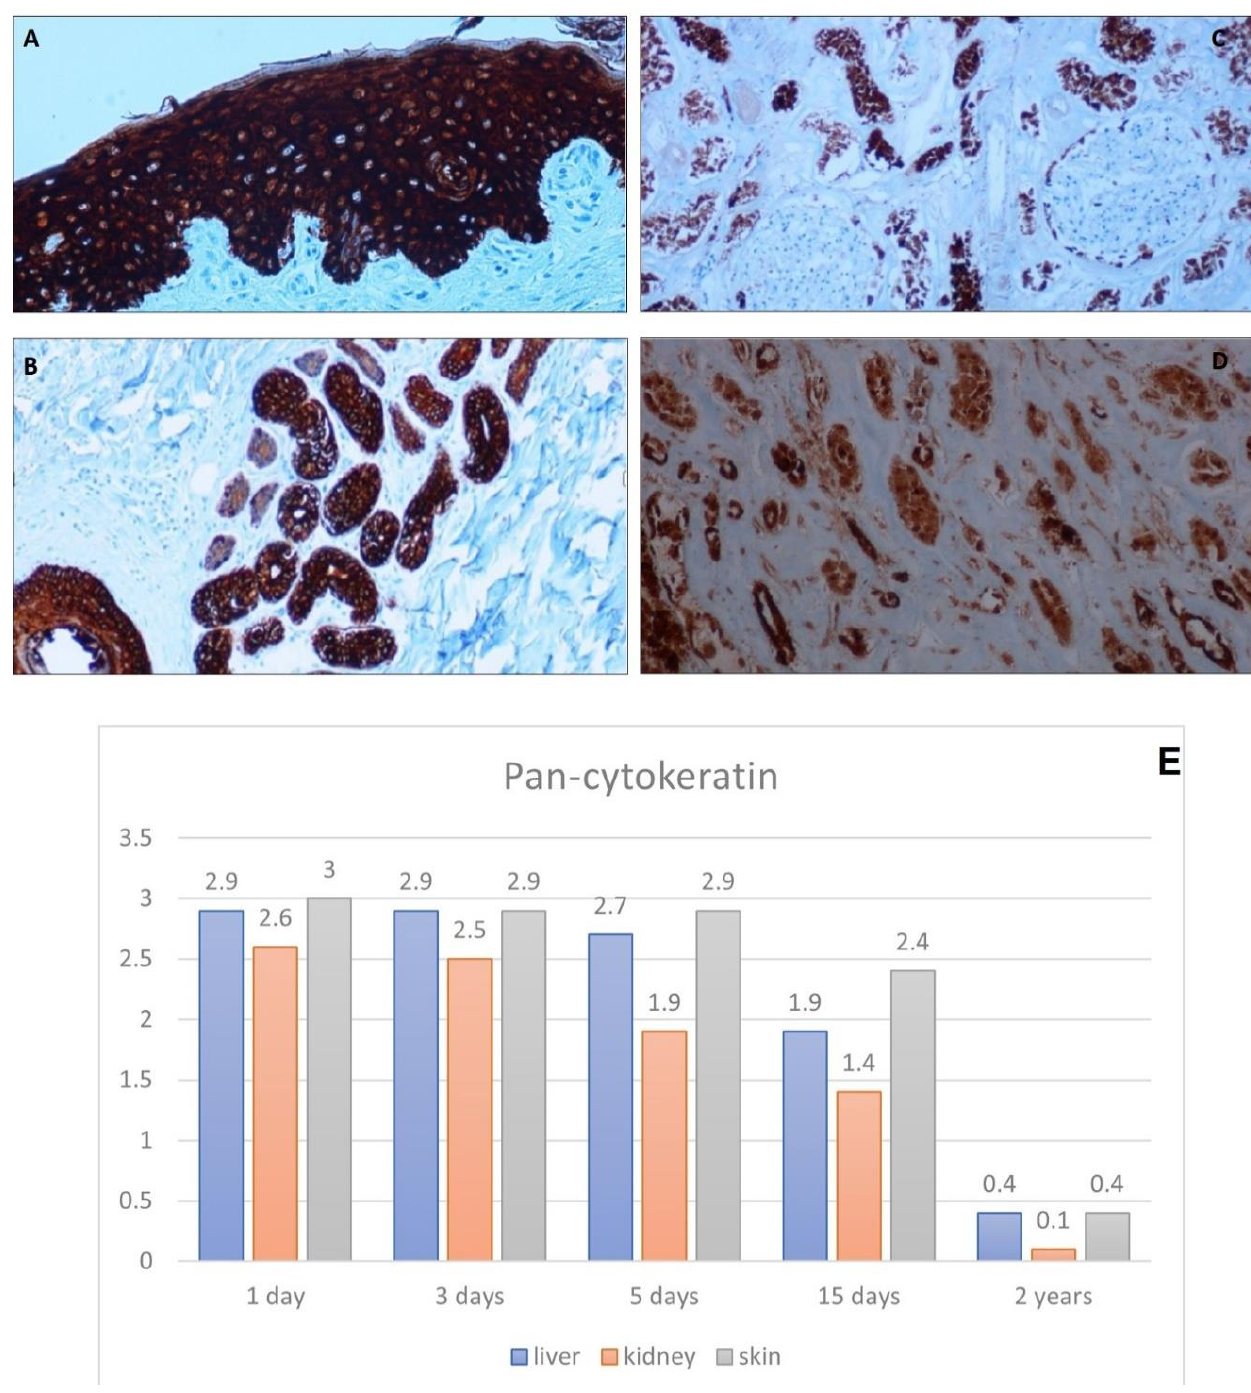
Figure 7. Immunohistochemical analysis of pan-Cytokeratin . ( A ) very high staining of pan cytokeratin in skin tissue taken 3 days after death, 20×. ( B ) Subcutaneous tissue taken 3 days after death displays high pan-cytokeratin expression, 10×. ( C ) High pan cytokeratin expression in a kidney taken 1 day after death, 10×. ( D ) Aspecific pan cytokeratin staining in a kidney tissue 5 days after death, 20×. ( E ) Graph shows the intensity of pan-cytokeratin immunostaining (score 0 – 3).